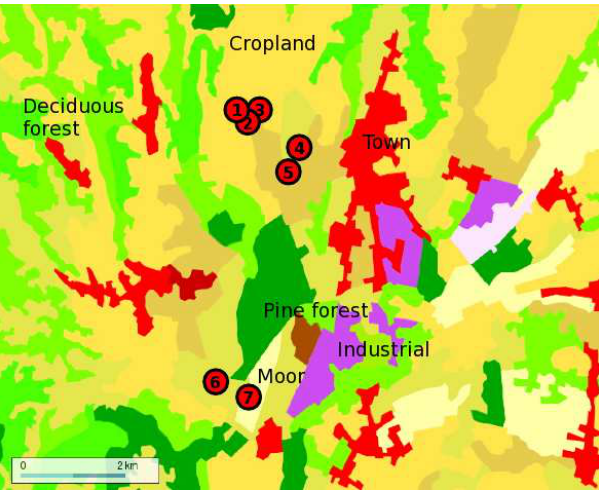
Figure 4. Land use surrounding the BLLAST site and location of the seven surface flux stations used to estimate the sensible and la- tent heat flux prescribed in the model experiments. The land types are cropland (yellow), deciduous forest (light green), urban (red), pine forest (dark green), industrial (purple) and moor